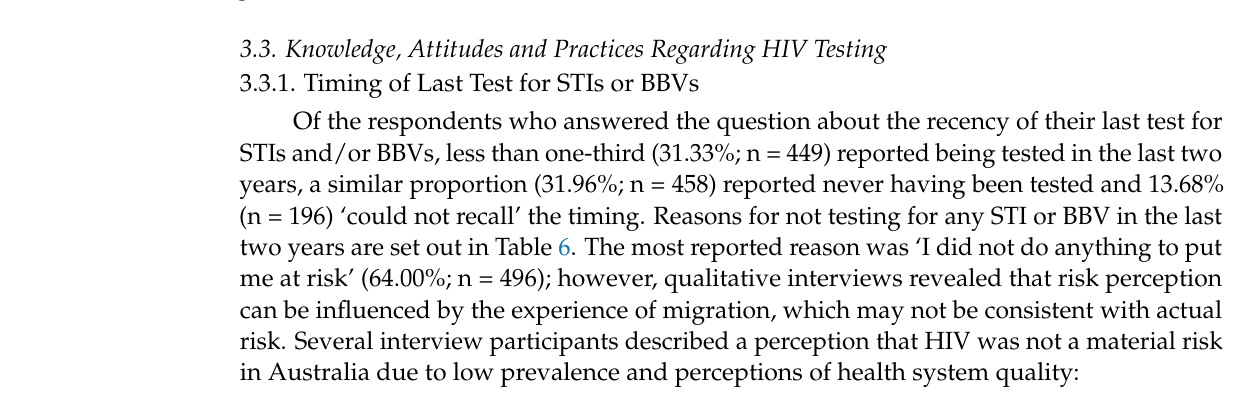
Table 6. Responses to reason for no STI/BBV test in last two years (Why did you NOT have an STI or BBV test in the last two years?) (n =